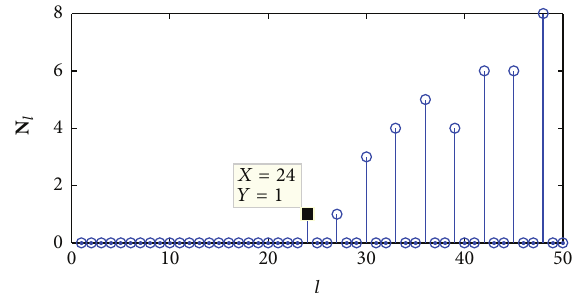
Figure 4: The recorded vector N 𝑙 based on incorrect synchroniza-